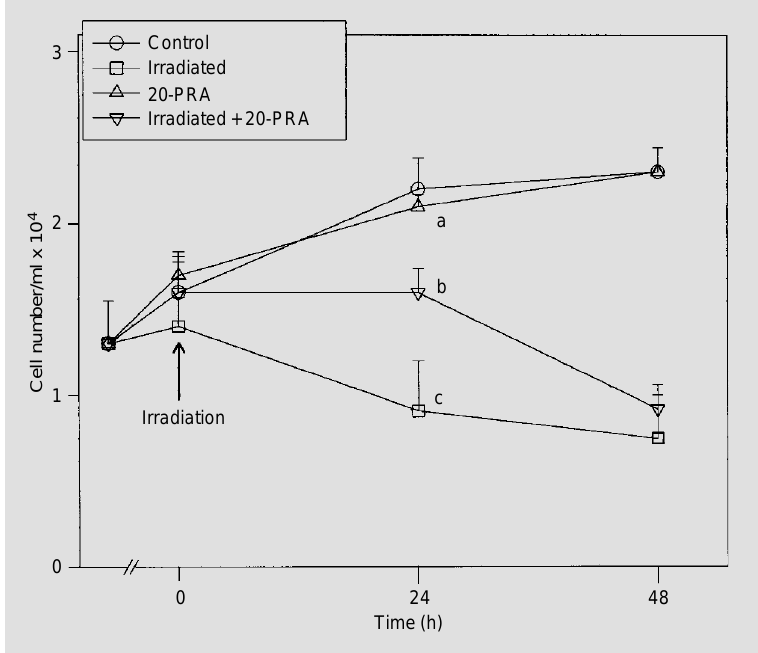
Figure 1 - The radioprotective effect of 20-PRA on K562 cells. Cells were incubated for 30 min with 1 nM 20-PRA and then irradiated with 5 Gy. After irradiation, the cells were incubated for 48 h. The viable cell number was determined by the Trypan blue technique. Data are reported as mean ± SEM for N = 3-7 experiments. a vs b, P = 0.07; a vs c, P = 0.005; b vs c, P = 0.02 measured by the Student-t